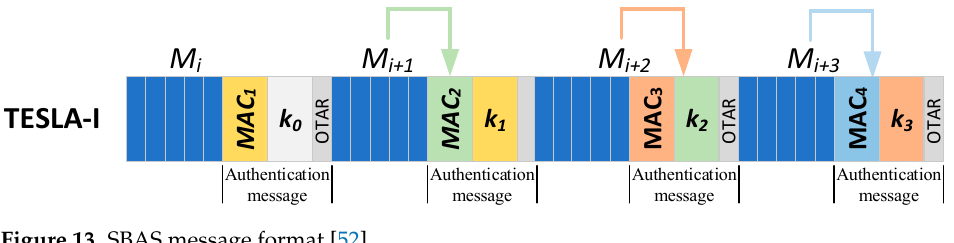
Figure 13. SBAS message format [52].